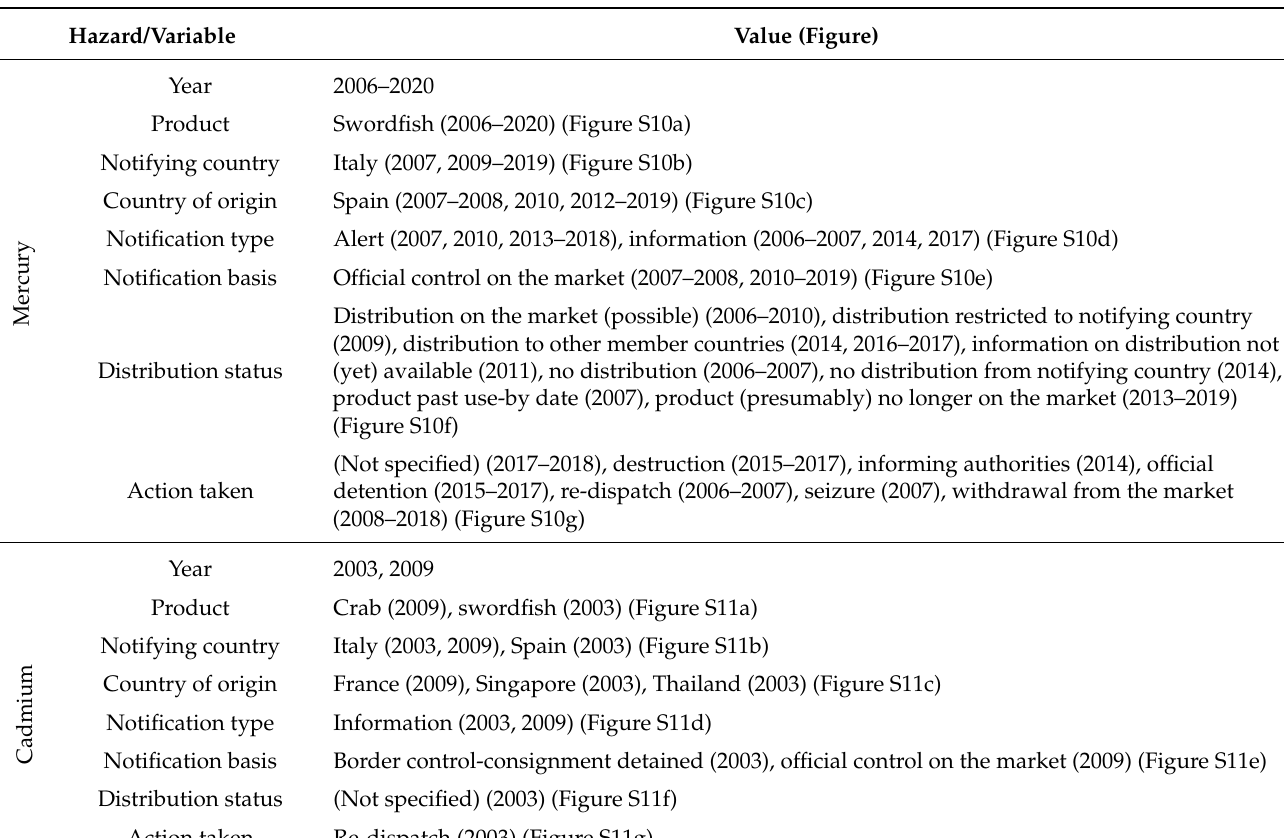
Table 6. Results of two-way joining cluster analysis related to notifications on heavy metals in